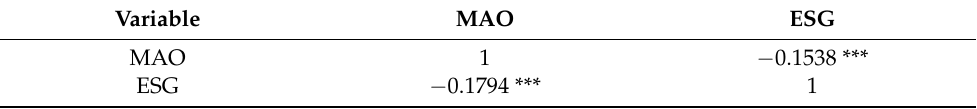
Table 3. Correlation matrix of the independent and dependent variables. Variable